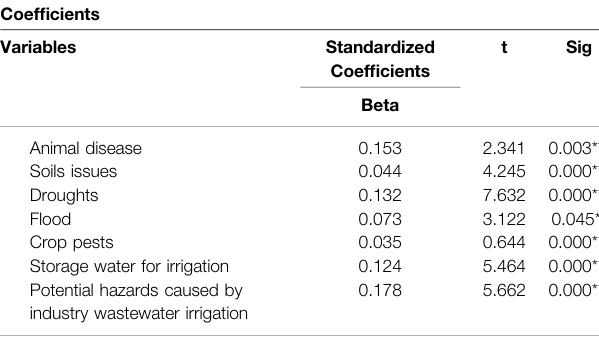
TABLE 3 | Linear regression. Coef fi